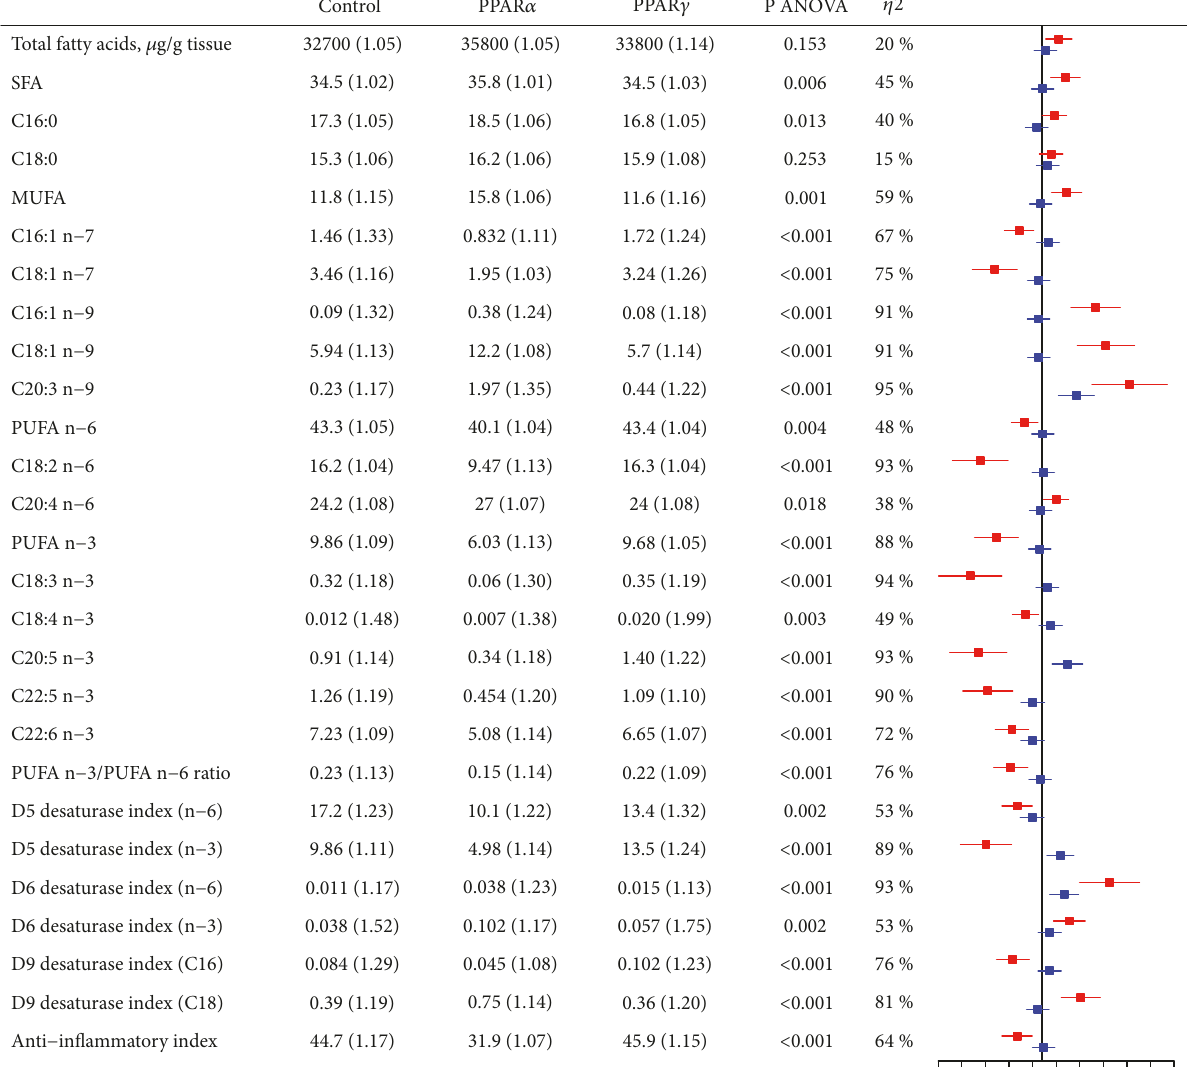
Figure 2: Hepatic fatty acid composition (wt%) in Wistar rats after treatment with PPAR agonists for 12 days. Values are geometric mean (gSD). Red bars correspond to PPAR 𝛼 vs control and blue bars to PPAR 𝛾 vs control. ANOVA, analysis of variance; MUFA, monounsaturated fatty acids; PPAR, peroxisome proliferator-activated receptor; PUFA, polyunsaturated fatty acids; SFA, saturated fatty acids. D5 desaturase index (n-6) = C20:4n-6 / C20:3n-6 (an indirect index of Δ 5 desaturase activity based on n-6 PUFA). D5 desaturase index (n-3) = C20:5n-3 / C20:4n-3 (an indirect index of Δ 5 desaturase activity based on n-3 PUFA). D6 desaturase index (n-6) = C18:3n-6 / C18:2n-6 (an indirect index of Δ 6 desaturase activity based on n-6 PUFA). D6 desaturase index (n-3) = C18:4n-3 / C18:3n-3 (an indirect index of Δ 6 desaturase activity based on n-3 PUFA). D9 desaturase index (C16) = C16:1n-7 / C16:0 (an indirect index of Δ 9 desaturase activity based on C16 SFA/MUFA). D9 desaturase index (C18) = C18:1n-9 / C18:0 (an indirect index of Δ 9 desaturase activity based on C18 SFA/MUFA). Anti-inflammatory index = ((C22:6n-3 + C22:5n-3 + C20:3n-6 + C20:5n-3) / C20:4n-6) ∗